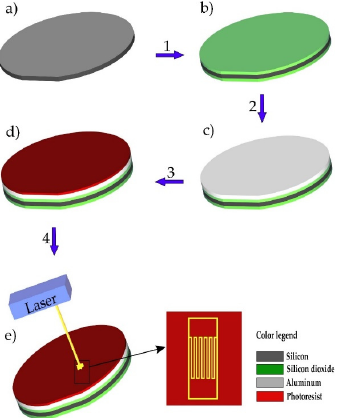
Figure 1. Depiction of the fabrication procedure: ( a ) Starting wafer; ( b ) thermal oxidation of the silicon wafer; ( c ) sputtering of aluminum 1% silicon; ( d ) spin coating of the photoresist; ( e ) exposure to laser light.